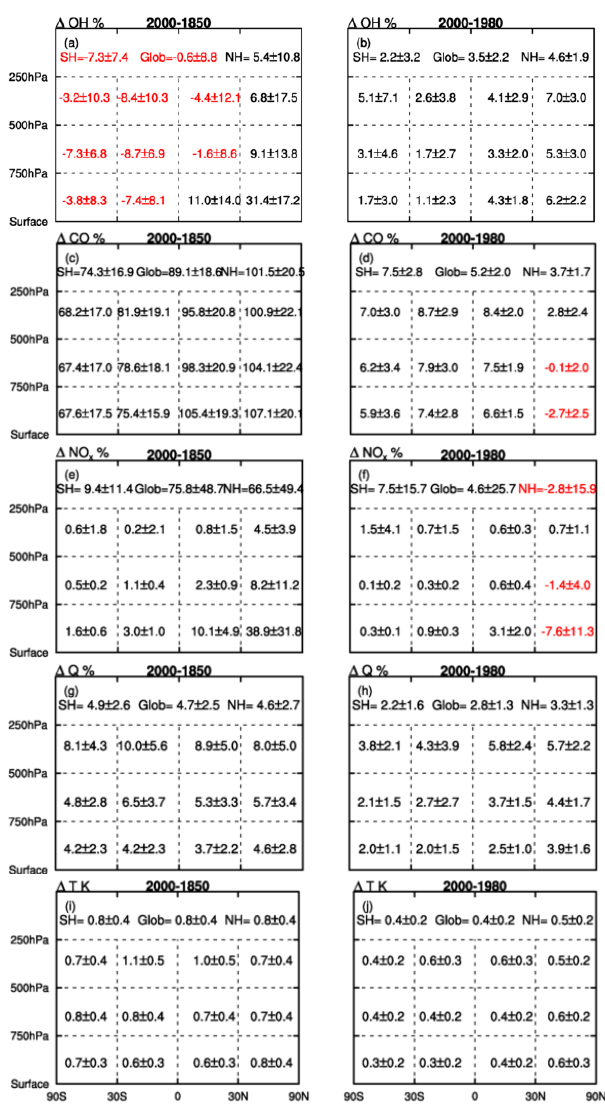
Fig. 3. Multi-model mean percentage change in tropospheric OH, CO and NO x burdens, humidity (Q), and absolute change in temper- ature for 12 subdomains of the atmosphere as defined by Lawrence et al. (2001) for 2000–1850 (left) and 2000–1980 (right). Decreases are shown in red and increases are in black. Changes in the mean global (Glob), Southern Hemisphere (SH), and Northern Hemi- sphere (NH) troposphere (surface to 200hPa) are shown in the top- most row of each